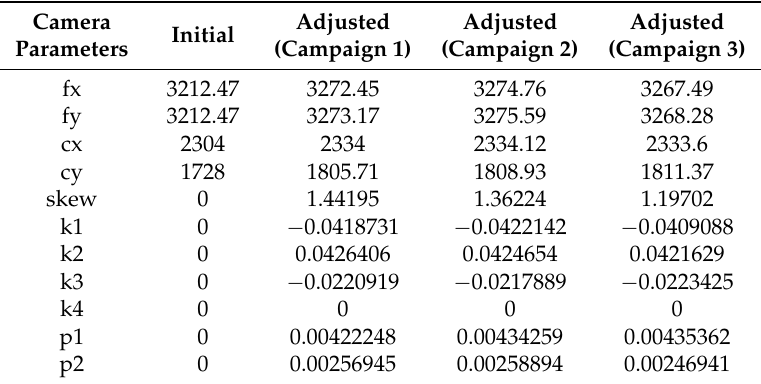
Table 2. Optimization of the camera parameters (pixel).